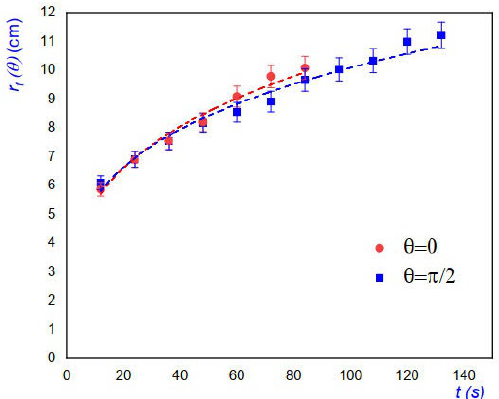
Figure 10. Plots of the condensation front r f ( θ , t ) along the vertical ( θ = 0) and horizontal ( θ = π /2) lines for different time periods. Measurements were made from images in Figure